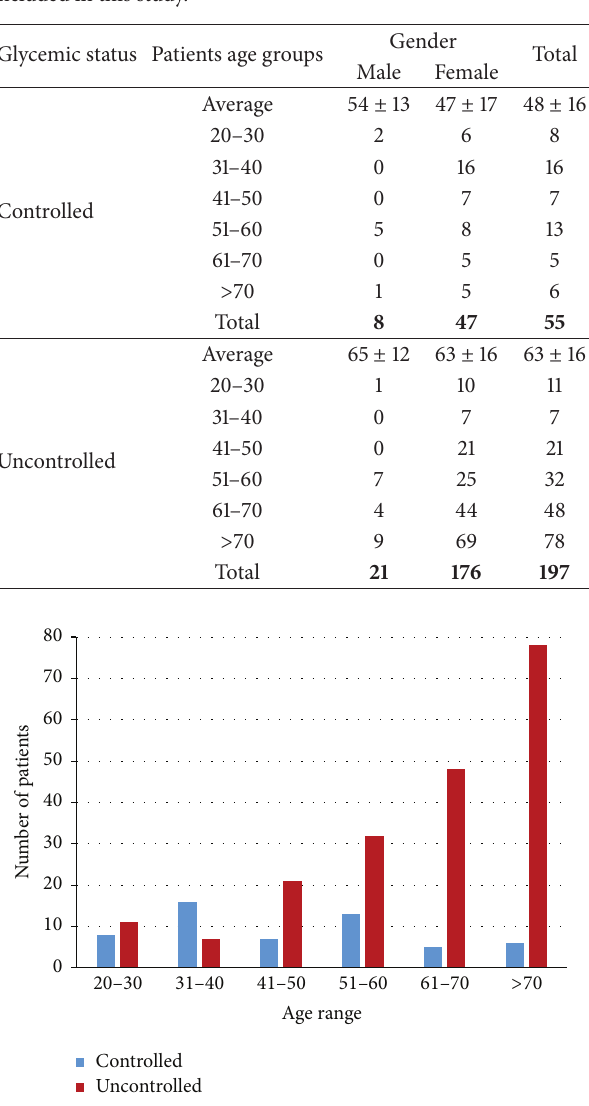
Table 2: Age and sex distribution of patients with positive UTI included in this study.